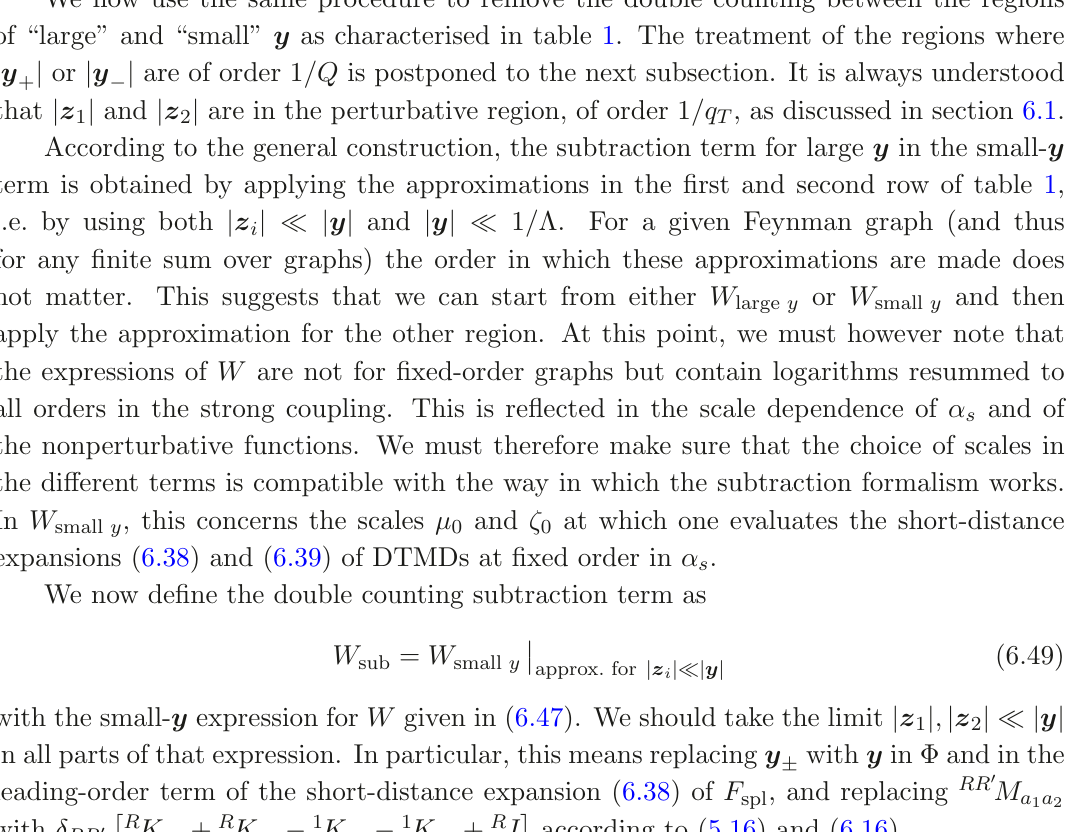
Γ. In [65] it was shown that if the approximation T r r ′